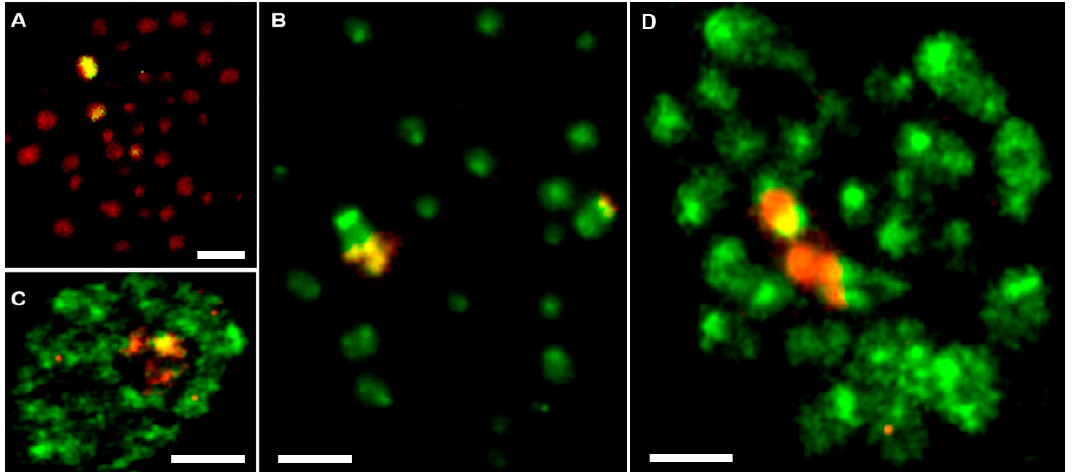
Figure 6. Fluorescence in situ hybridization (FISH) with the 28S rDNA probe and interspecies CGH results visualizing rDNA regions. ( A ) 28S rDNA FISH to E. virens chromosomes (red) showing three hybridization signals (yellow); ( B ) 28S rDNA FISH to chromosomes of H. incongruens (green) with three hybridization signals (yellow); ( C ) interspecies CGH experiments between E. virens (red, whole-genome DNA) and H. incongruens (green, nucleus and DNA) showing the red signal in the nucleolar region; ( D ) reciprocal CGH experiment to C/on E. virens chromosomes (green) with a whole-genome DNA probe of H. incongruens . Scale bars indicate 3 µm.